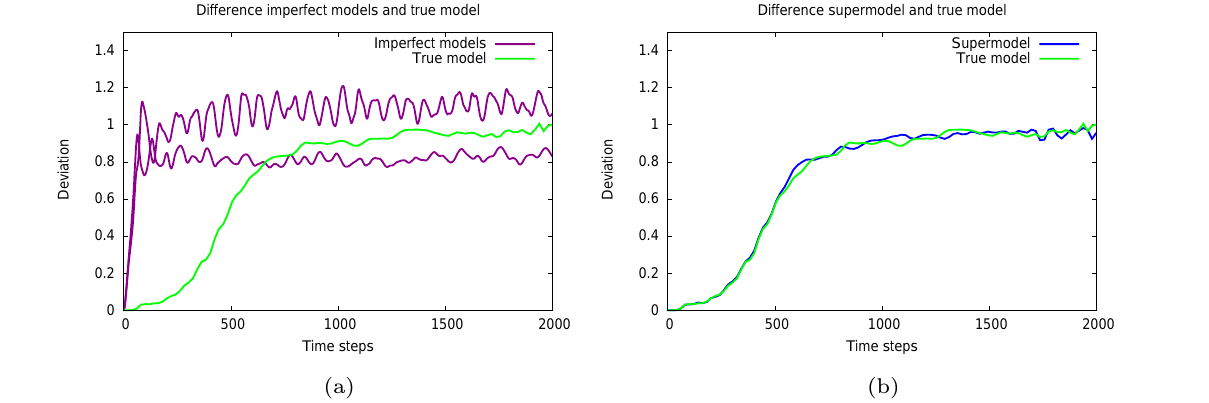
Figure 5. Forecast quality of the imperfect Lorenz 63 models (purple) and the supermodel (blue) compared to the true Lorenz 63 model (green).